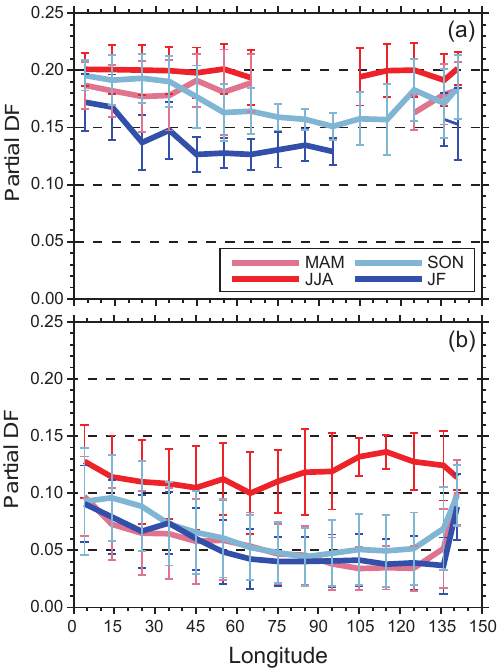
Figure 8. Partial degree of freedom (DF) for GOSAT/TANSO-FTS TIR CO 2 data in the upper troposphere (a) and the lower strato- sphere (b) for each area of the flight between Tokyo and Europe (NRT_DME_AMS). The means and their 1 σ standard deviations of the partial DF data were calculated in spring (MAM), summer (JJA), fall (SON), and winter (JF), as shown by the pink, red, light blue, and blue lines,